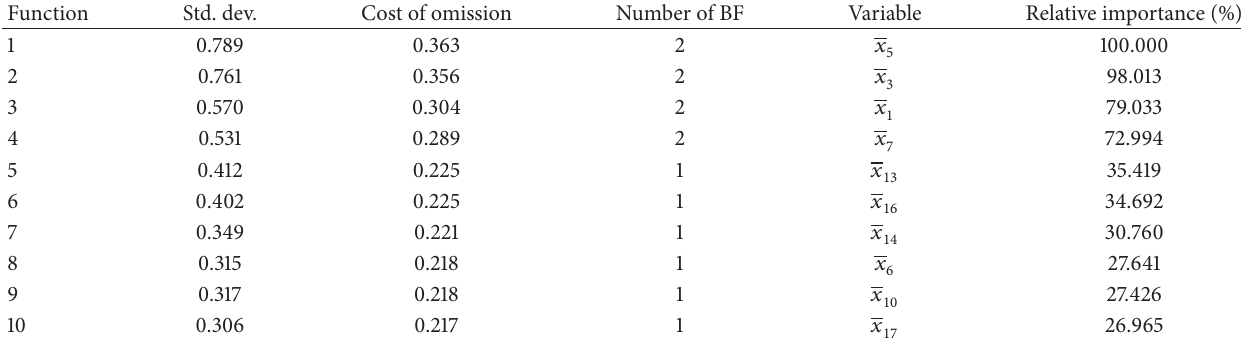
Table 7: Basis functions and important explanatory variables for the MARS model with ( 𝜌 , 𝛿 𝑖 ) = (0.9, 0.5).